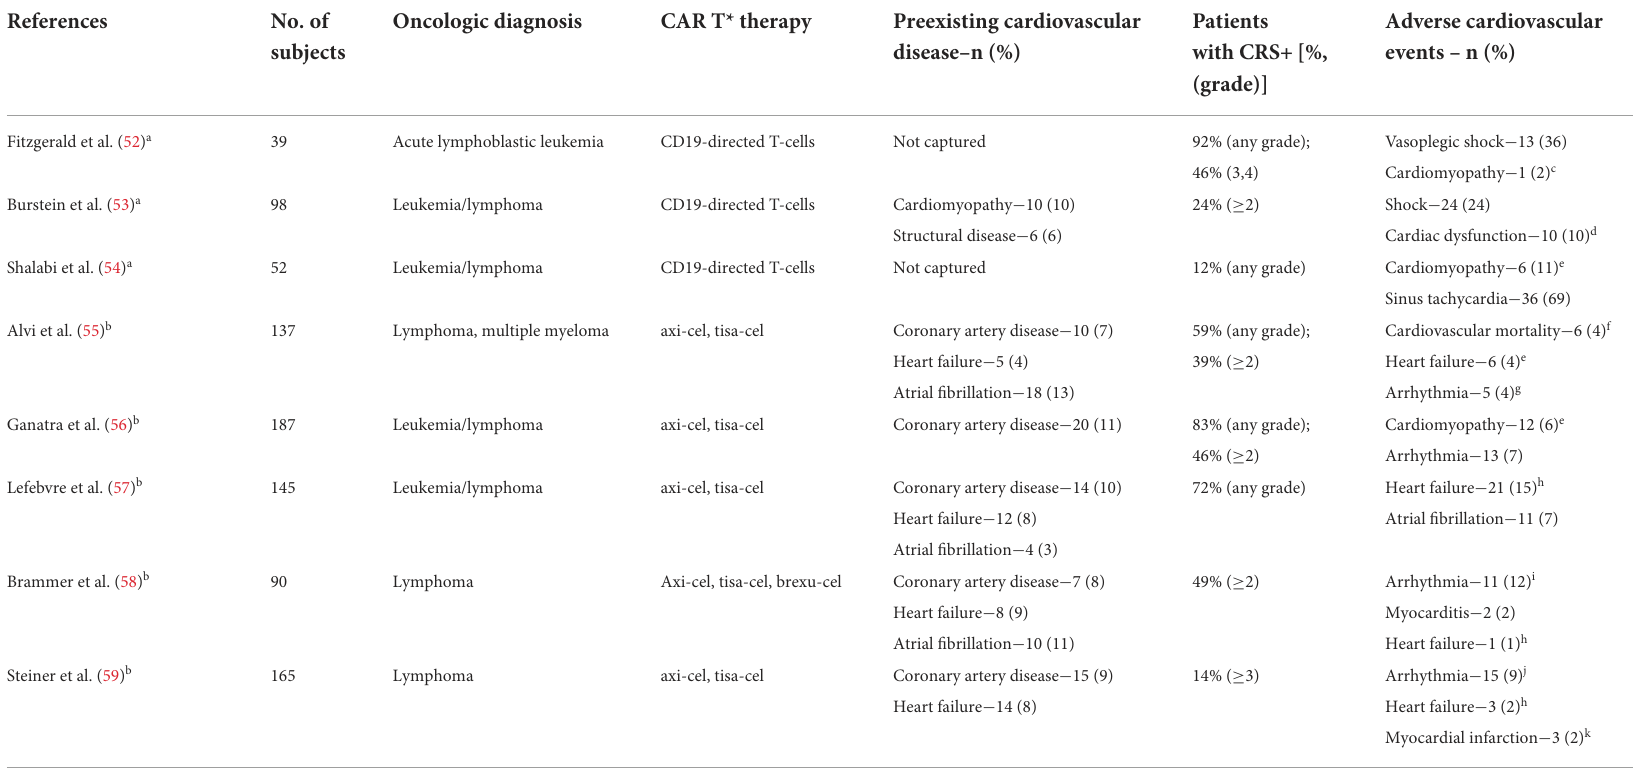
TABLE 2 Summary of pediatric and adult studies investigated cardiovascular complications and CAR T-cell